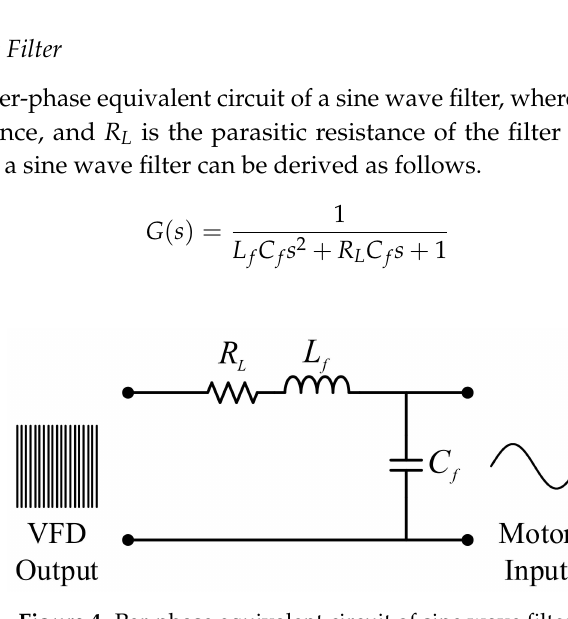
Figure 4. Per-phase equivalent circuit of sine wave filter.